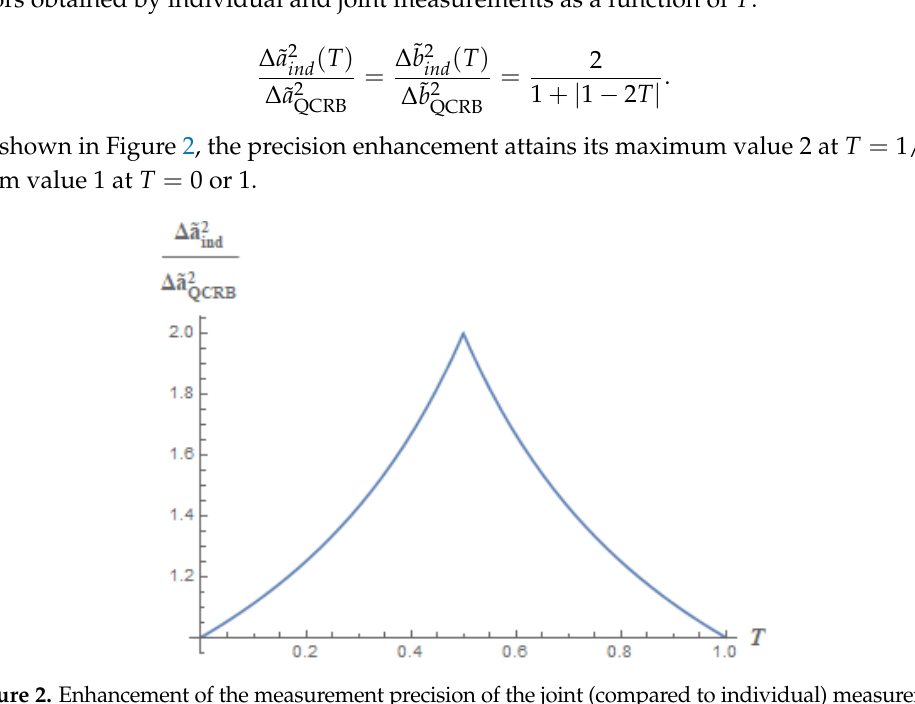
Figure 2. Enhancement of the measurement precision of the joint (compared to individual) measurement as a function of the beam splitter transmissivity T . This is calculated as the reduction of the error variance for the joint measurement attaining the QCRB with respect to the error variance of the optimal individual